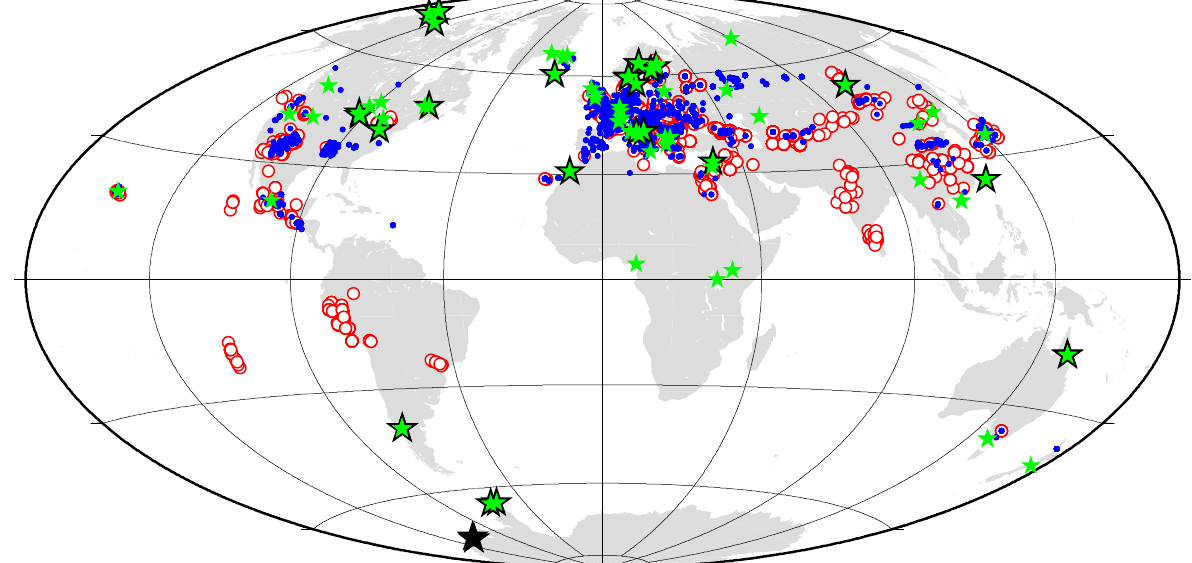
Fig. 1. Distribution of available Holocene archeo- and paleomagnetic data (status as described by Donadini et al. 2009 and Korte et al. 2011). Archeointensities (red circles) and particularly archeomagnetic directions (blue dots) are scarce in the southern hemisphere. Sediment relative intensity (black stars/black borders around green stars) and directional (green stars) records provide a somewhat better global